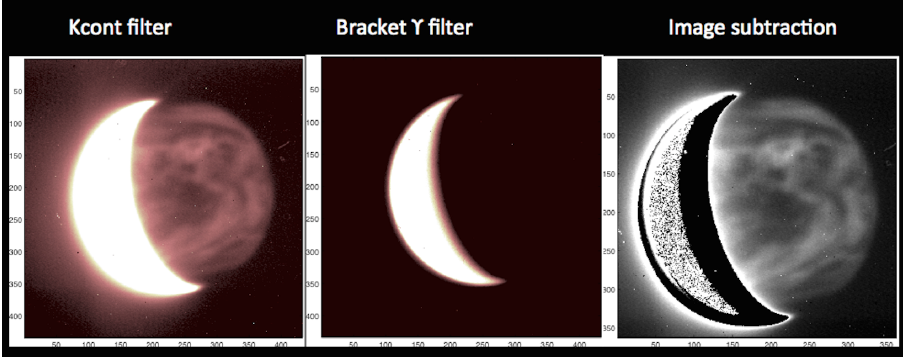
Figure 3. From left to right, a continuum K image, an image obtained with a Bracket gamma filter, and the result of subtracting a Br γ image from the one taken with k cont . On these images, the dark regions are clouds, the bright regions are optically thinner areas between the clouds that allow thermal emission from the lower atmosphere to escape, and the outlined crescent is the saturated dayside of the planet. Images from 11 July